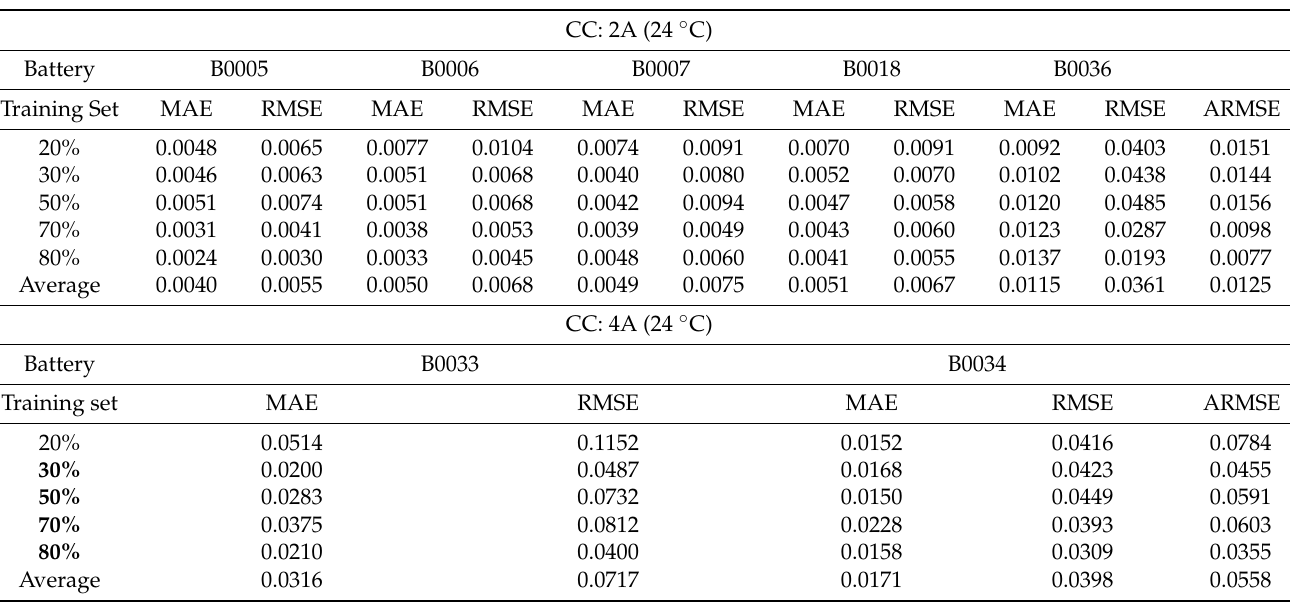
Table 2. The values of the MAE, RMSE, and ARMSE of the SOH estimation using the SR model on batteries discharged at 2A and 4A, respectively. The temperature was 24 ◦